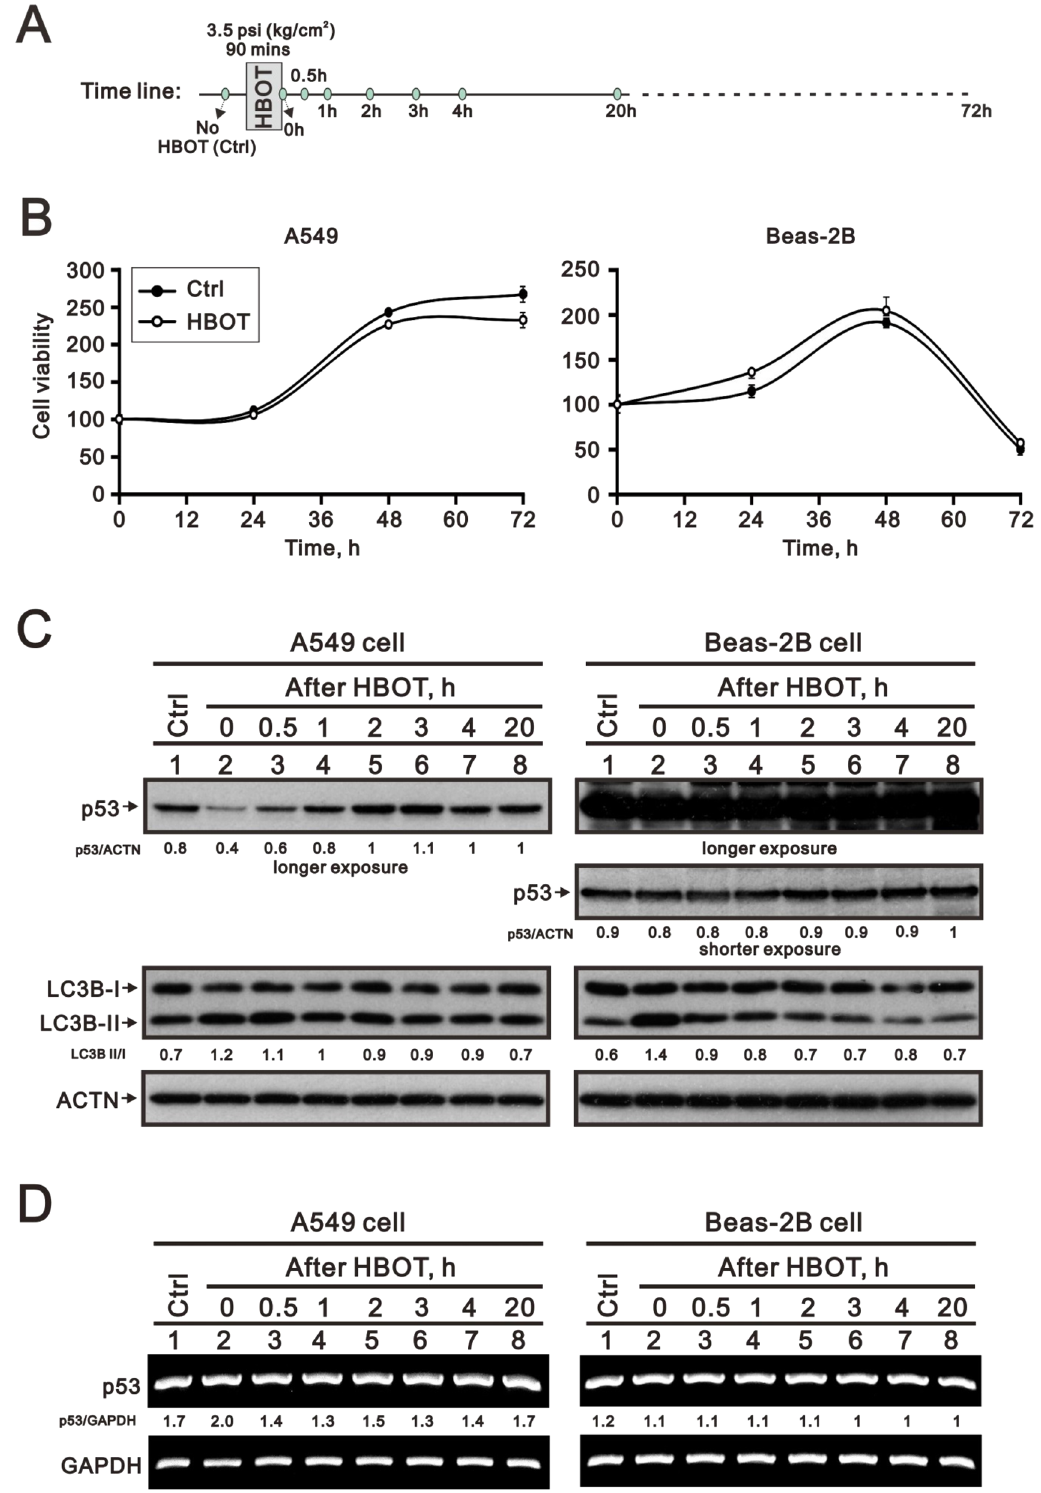
Figure 5. The HBOT protocol and its transient effect on A549 and Beas-2 cell lines. ( A ) The HBOT protocol was applied in A549 and Beas-2 cell lines. ( B ) The cell viability profiles were analyzed in A549 and Beas-2 cell lines. ( C , D ) The HBOT A549 and Beas-2 cells were treated with indicated conditions and then cell lysates were subject to the ( C ) Western analysis for antibodies against p53, LC3B, and control protein ACTN and ( D ) RT-PCR analysis for p53 mRNA and control GAPDH mRNA. The results were representative of two independent experiments. Quantitative analysis of the western blot was listed under each